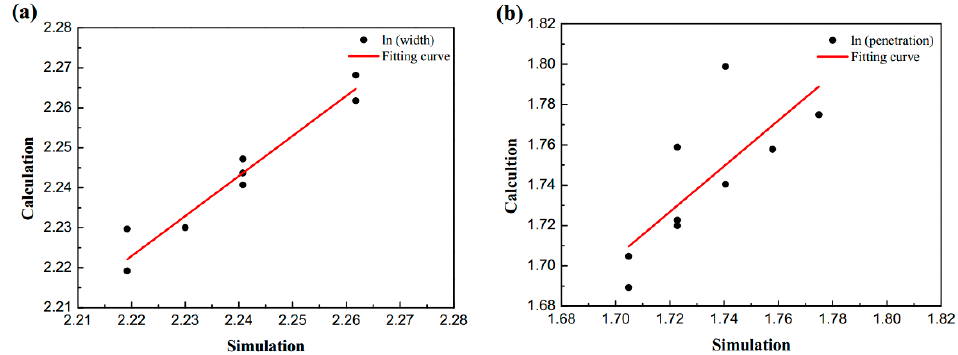
Figure 5. Verification of regression results in sensitivity analysis: ( a ) ln (width); ( b ) ln (penetration).